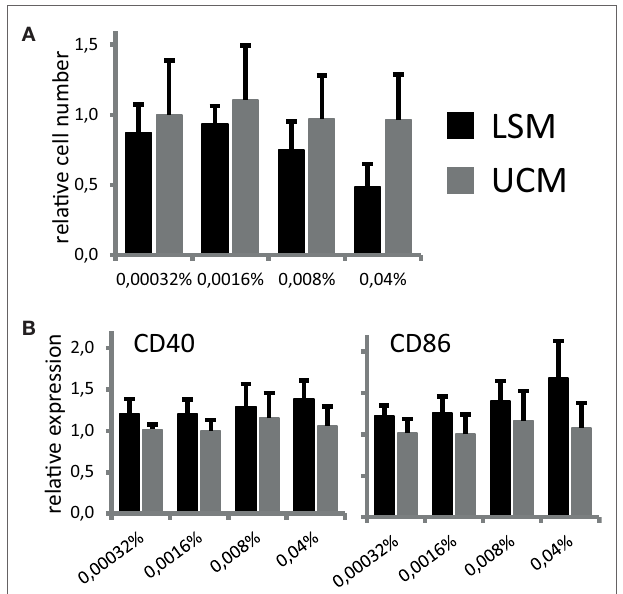
FigUre 1 | LGG soluble mediator (LSM) does not affect dendritic cells after 6 days of differentiation as described in Section “Materials and Methods” in the presence of LSM or UCM. (a) Relative number of CD11c + cells after 6 days of culture. Cell counts for each incubation condition were divided by the number of cells cultured in control condition (without addition of LSM or UCM). All cells harvested at day 6 were CD11c + . (B) Expression of CD40 and CD86, based on mean fluorescence intensity, after 6 days of culture with LSM or UCM relative to expression on control cells. Data are presented as average of at least three independent cultures ± SEM (* p < 0.05).